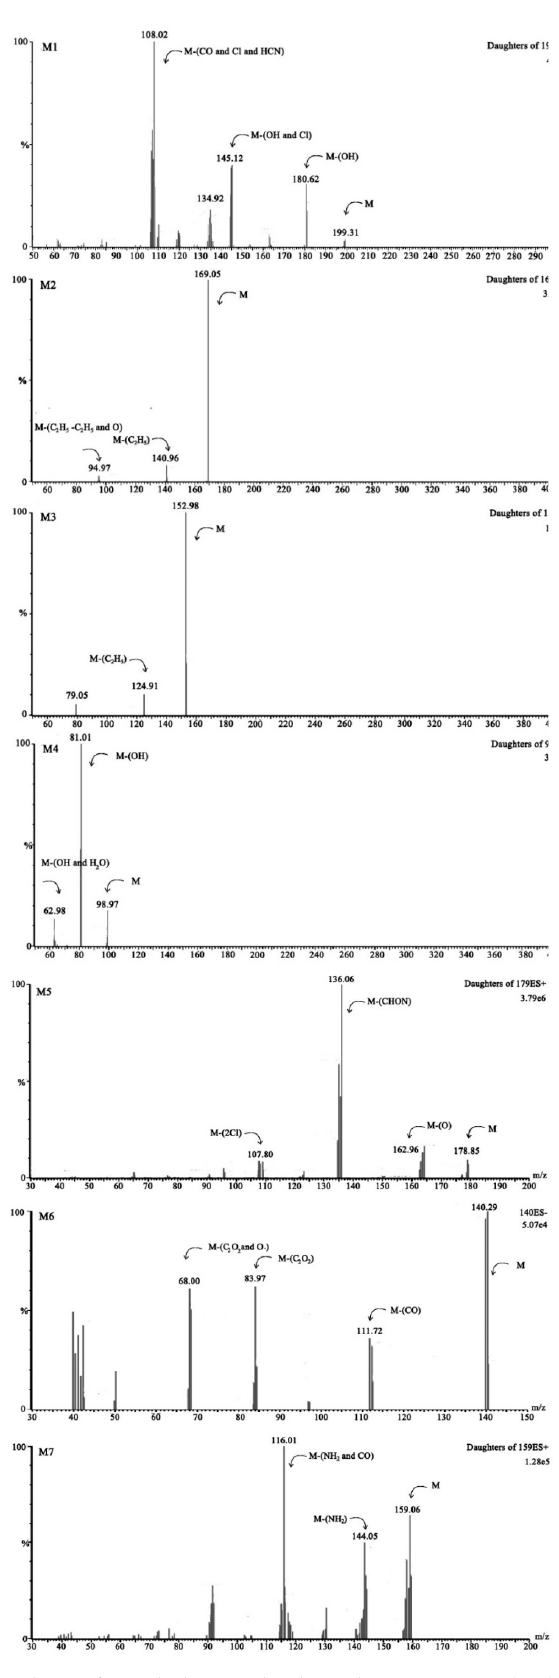
Figure 4. LC-MS / MS analysis of metabolites in the degradation process. (M1) TCP, (M2) DETP, (M3) DEP, (M4) H3PO4, (M5) DCPD, (M6) DHPD, (M7) ATOPA.